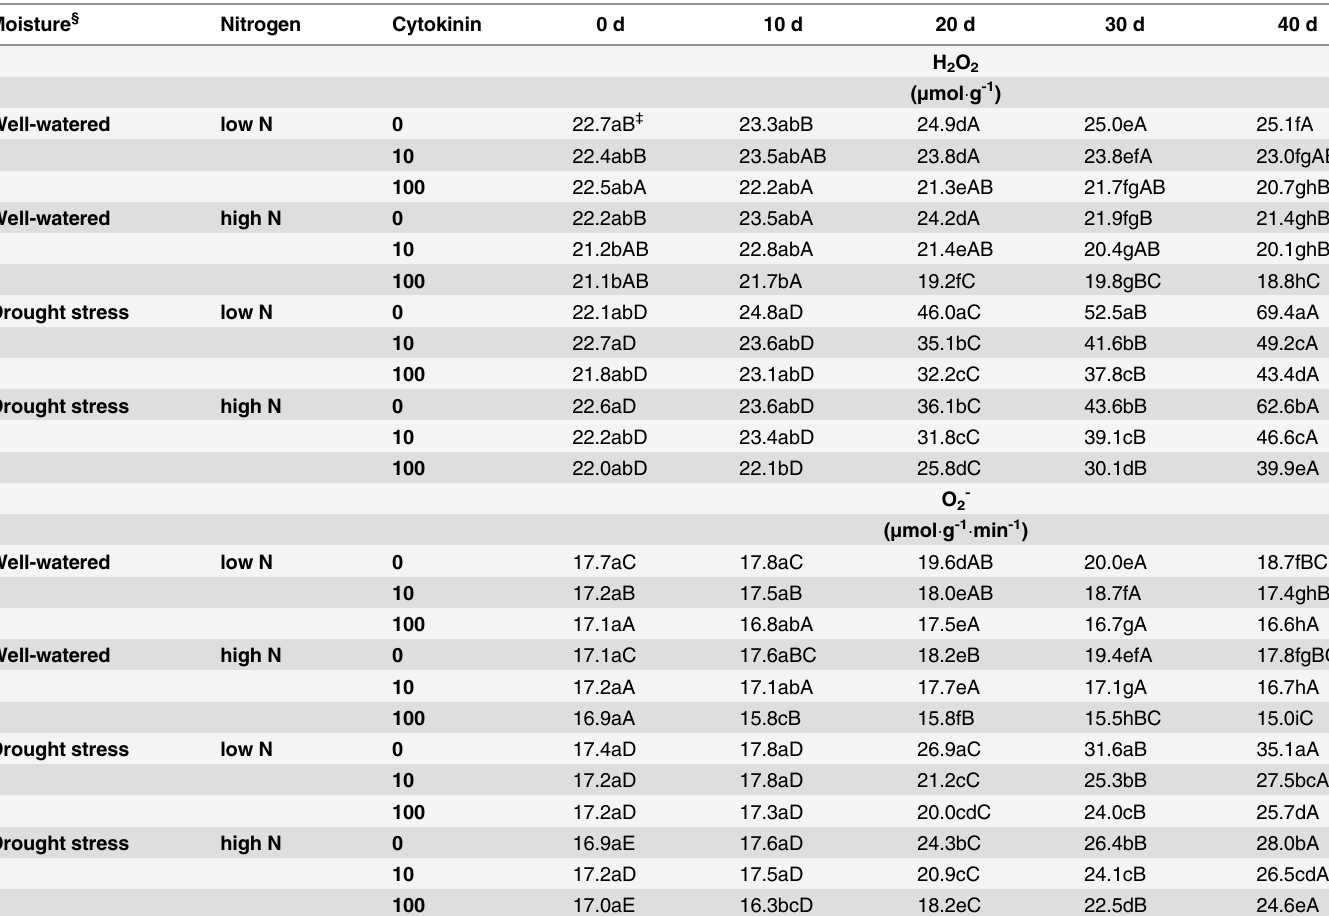
Table 3. Cytokinin and nitrogen impact on hydron peroxide (H 2 O 2 ) concentration and superoxide radical (O2 - ) production rate of creeping bent- grass subjected to two moisture regimes. Moisture